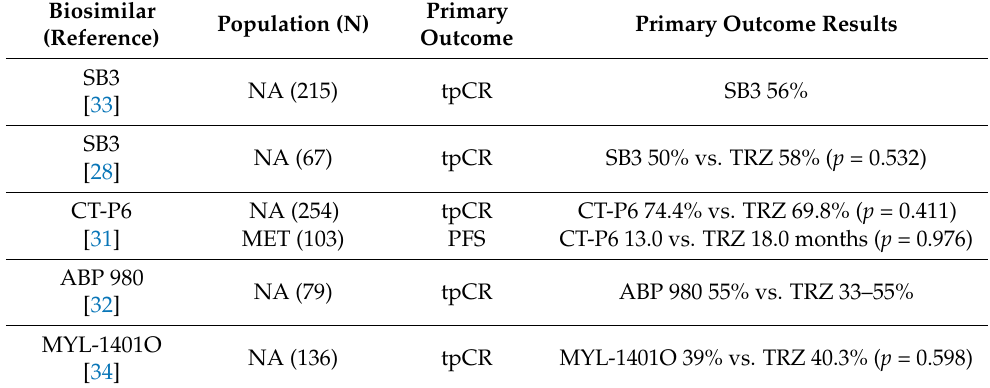
Table 2. Real world effectiveness of trastuzumab biosimilars in retrospective